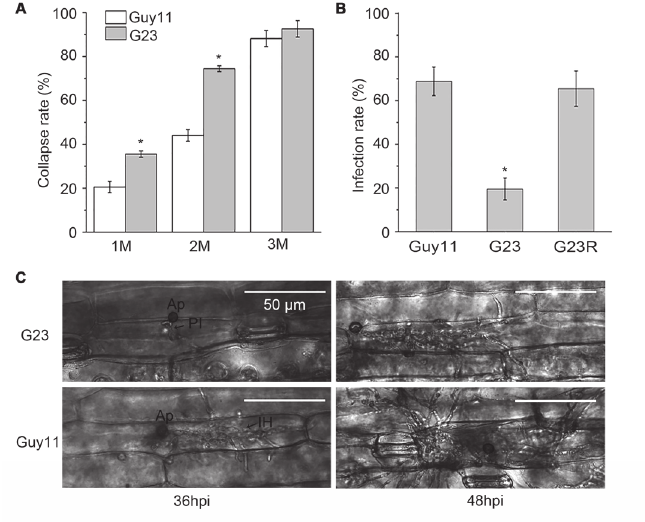
Fig 6. Analysis of infection-related morphogenesis of MoSFA1 deletion mutant. (A) Cytorrhysis assay using glycerol was performed to compare the appressorial turgor pressure of MoSFA1 mutant and wild-type strain. Different glycerol solutions were given to appressoria at 48 hpi. Appressorial cytorrhysis was counted under an optical microscope. The rate of cytorrhysis was the average of three replications. (B) Infection rate of M . oryzae strains in barley leaf cells at 36 hpi. (C) Growth of infectious hyphae of MoSFA1 deletion mutant was retarded in barley leaf cells. Penetration and infectious hyphae were examined under optical microscopy. Ap, appressorium; PI, primary infectious hyphae; IH, secondary infectious hyphae. Significant difference analysis was performed after percentages were arcsine transformed. The original percentages were used for presentations. Error bars represent SD. Asterisks in each data column indicate significant differences at p = 0.05.